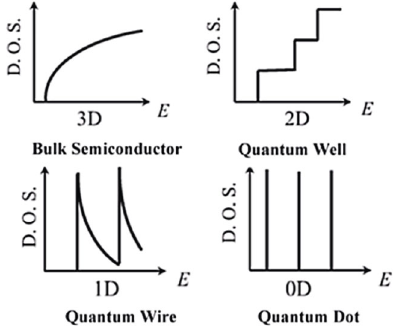
Fig. 6 Electronic density of states of different dimensions. Reproduced with permission from Ref. [122], © WILEY- VCH Verlag GmbH & Co. KGaA, Weinheim 2007.